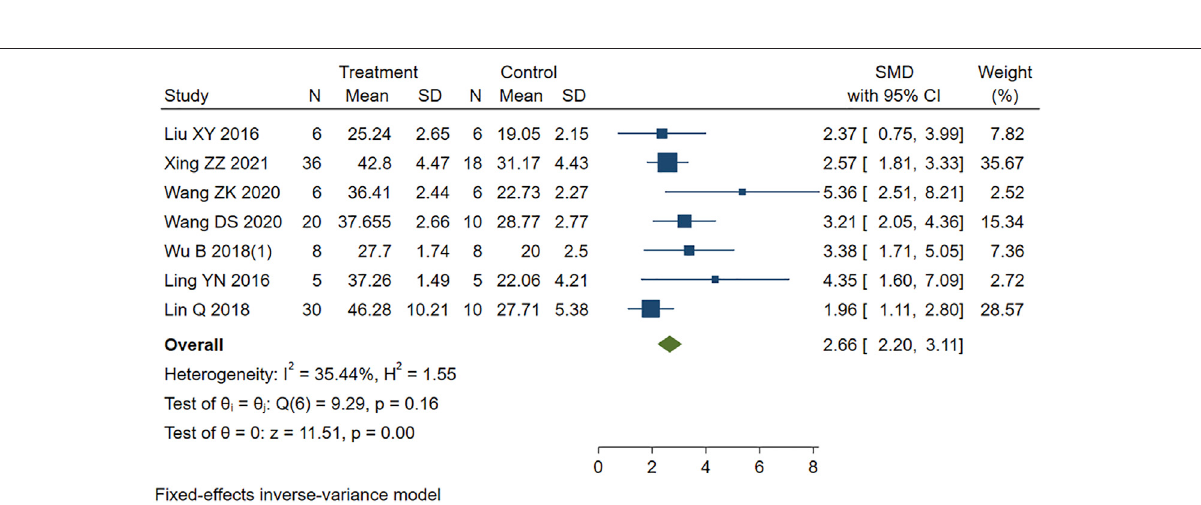
Frontiers in Pharmacology |